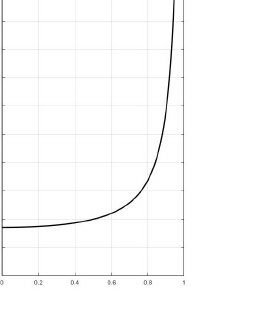
Figure 10. The part of Figure